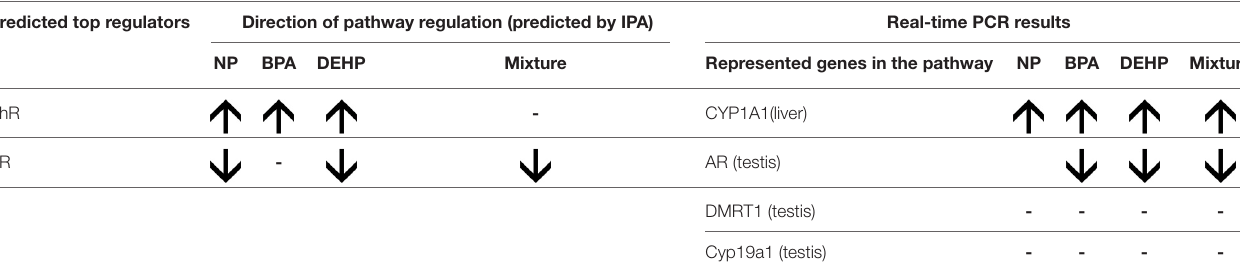
TABLE 6 | Comparison of top regulators predicted by IPA (fisher exact test p < 0.05) and gene expression of representative genes of the pathway using qPCR (ANOVA followed by Tukey Test, P < 0.05, n = 12). Predicted top regulators Direction of pathway regulation (predicted by IPA) Real-time PCR